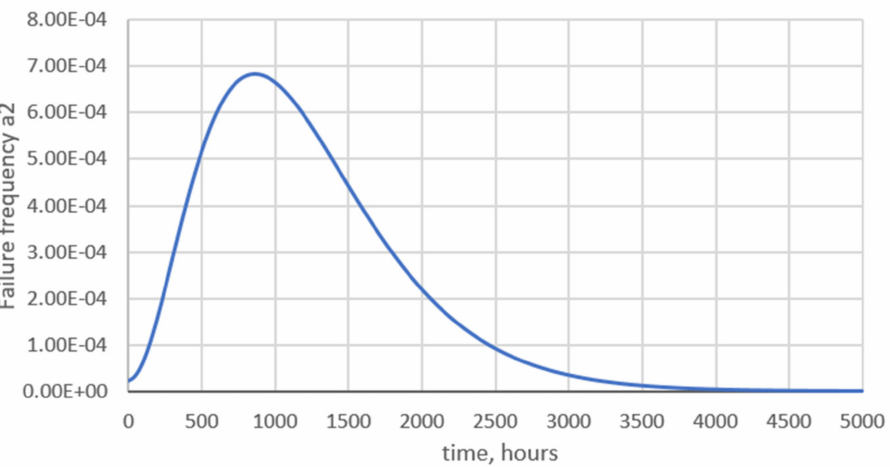
Figure 5. The failure frequency of the hierarchical ramified system in the availability condition k =